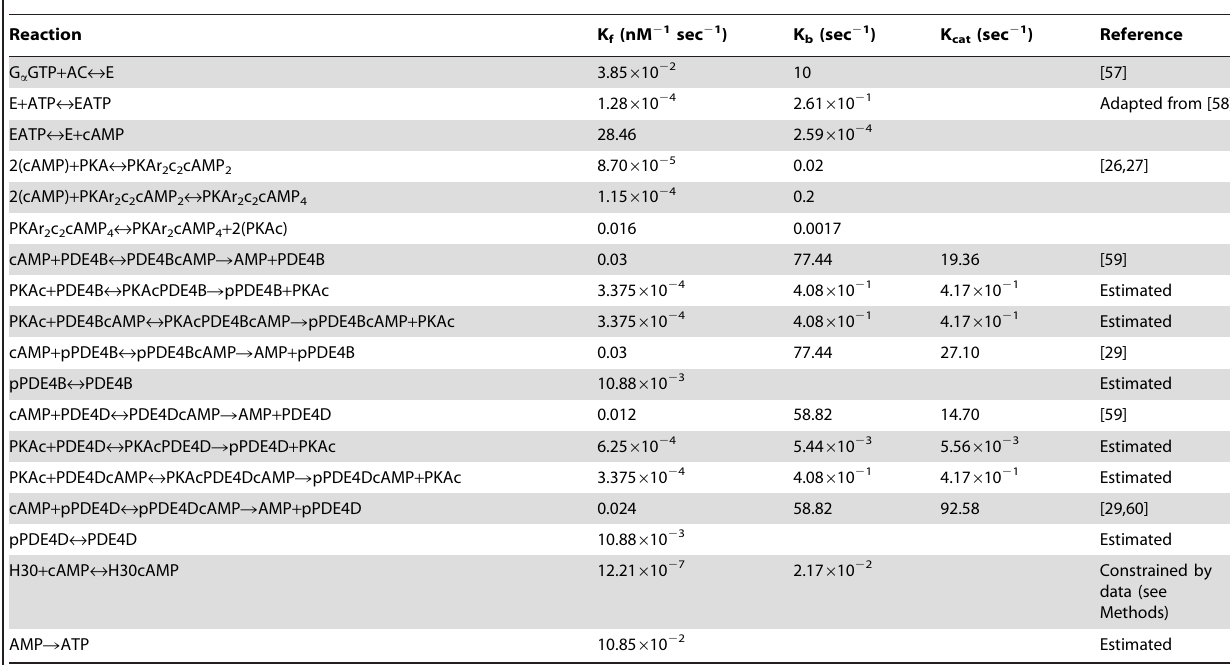
Table 1. Reactions and rate constants of HEK293 cell biochemical network.